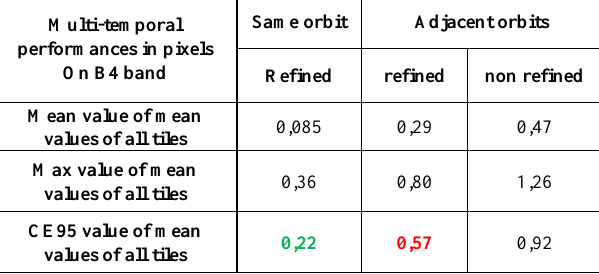
Table 8. Statistics on multi-temporal performances for L1C products on same or adjacent relative